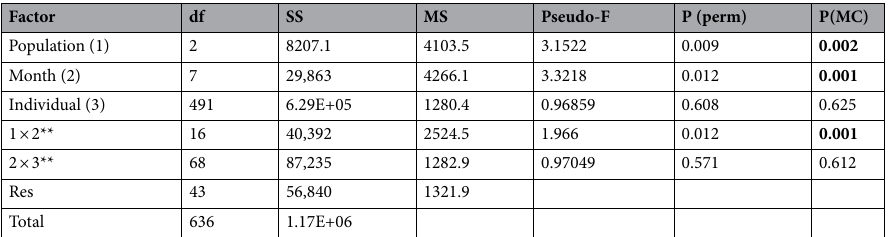
Table 3. Summary of the results of a PERMANOVA analysis testing the effects of the factors “population” (fixed), “month” (fixed, repeated) and “individual” (random, nested within “population” on Speleomantes italicus dietary habits. In bold significant ( P < 0.05) factors. **Term with one or more empty cells.